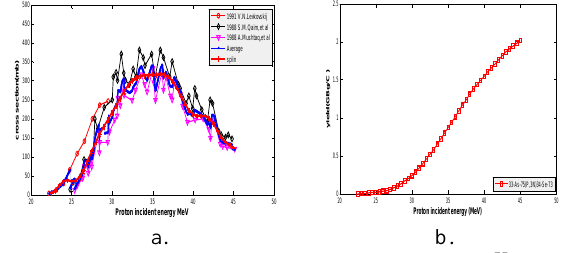
Figure 1 : a. Average cross sections of the reaction 75 As (p,3n) 73 Se . b. Isotopes production yield for the reaction 75 As (p,3n) 73